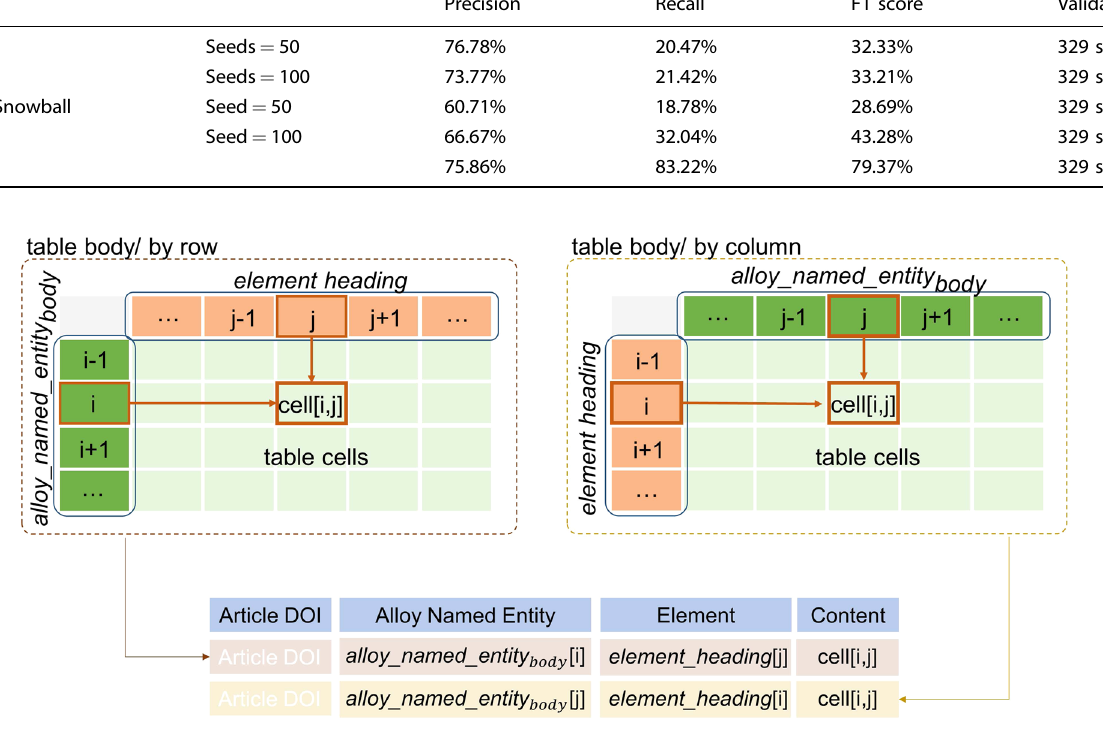
Fig. 4 Schematic of table relation extraction algorithm. Table direction ( “ by row ” or “ by column ” ) is fi rst detected by estimating the row or column location of the target information in the table body, e.g., chemical elements. Alloy named entities in green cells and elements in orange cells are jointed by the row and column index of each table cell from corresponding sequences respectively, and fi nally written into a quaternary-tuple <article DOI, alloy named entity, property speci fi er(element), property